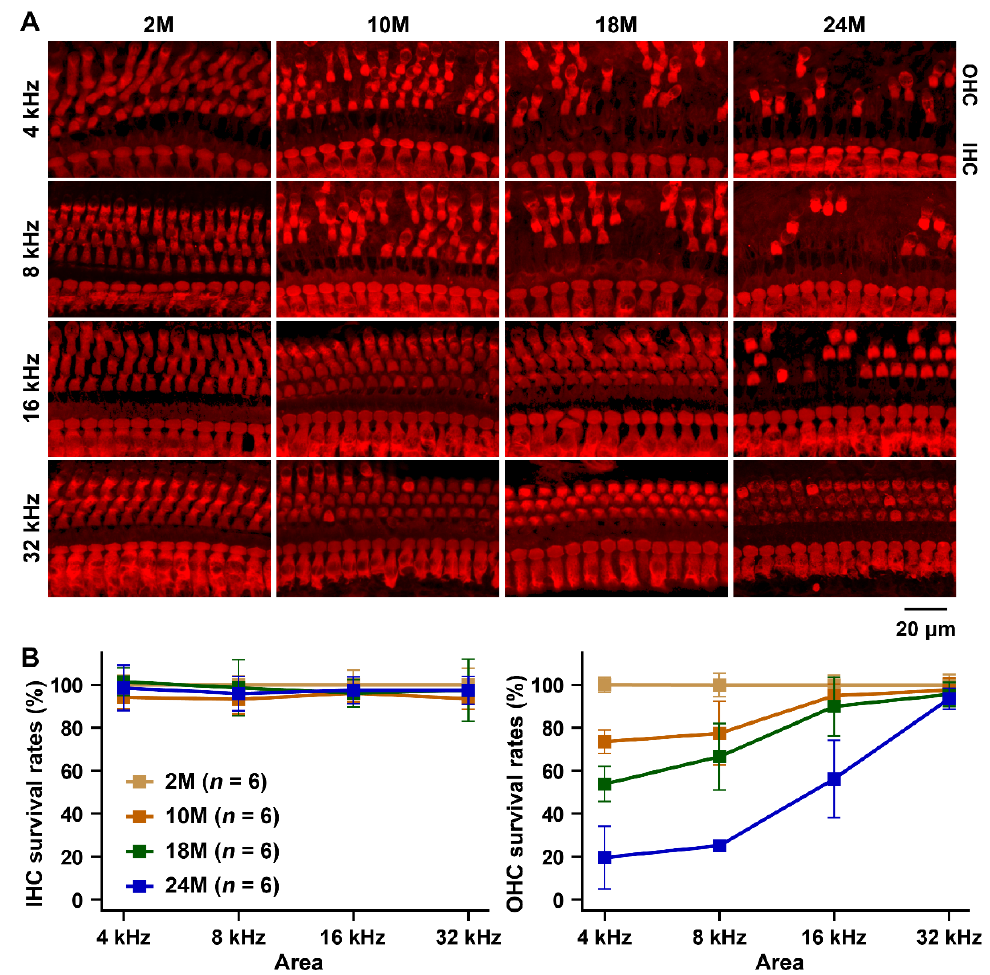
Figure 4. Decrease and/or maintenance in the IHC and OHC survival in aging MSM strain: ( A ) Representative confocal images of MYO6-positive IHCs and OHCs signals within the 4, 8, 16, 32 kHz areas of the cochlea from male mice of the MSM strain at 2, 10, 18, and 24 months of age. ( B ) Percentage of surviving IHCs and OHCs at the 4, 8, 16, 32 kHz areas in the cochlea of male mice of the MSM strain at 2, 10, 18, and 24 months of age. The means (squares) and SDs (error bars) of the IHC and OHC survivors are shown in each line graph. The mean numbers (Figure 2) of IHCs and OHCs from each area in the MSM strain at 2 months of age were assigned an arbitrary value of 100%.